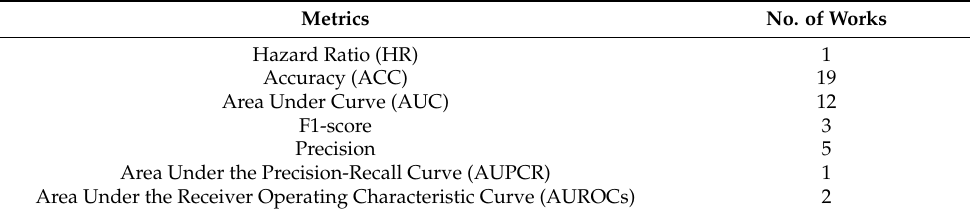
Table 5. Performance metrics applied to the algorithms in the observed